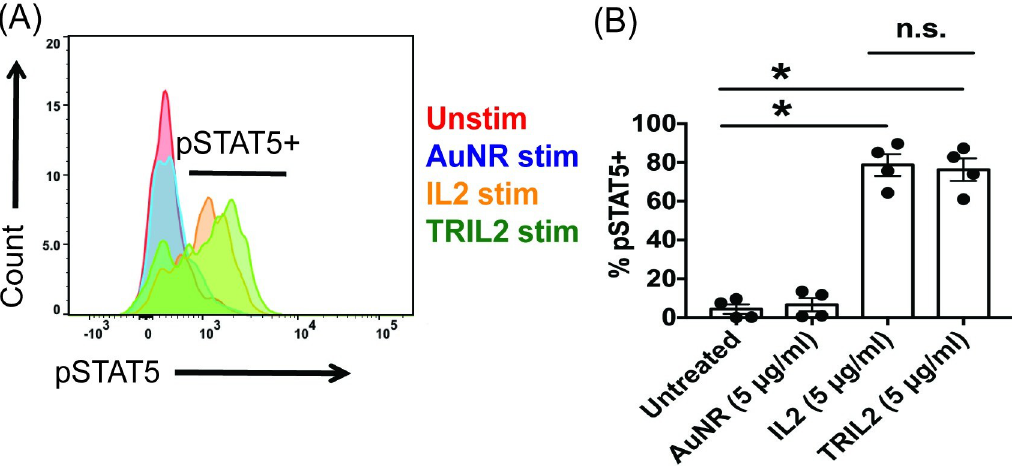
Fig 5. TRIL2 can functionally stimulate pSTAT5 in CD4+ CD25+ Foxp3+ Tregs. (A) TRIL2 stimulated CD4+ CD25+ Tregs to upregulate pSTAT5; black horizontal bar indicates pSTAT5+ cells. (B) Quantification of pSTAT5. The flow data are gated on the percent live. The data are representative of 2 independent experiments; n = 4 per group. The data is represented as scatter dot plots, where error bars represent the standard error of the mean and � p � 0.05 is significant as determined by a two-sided t test.